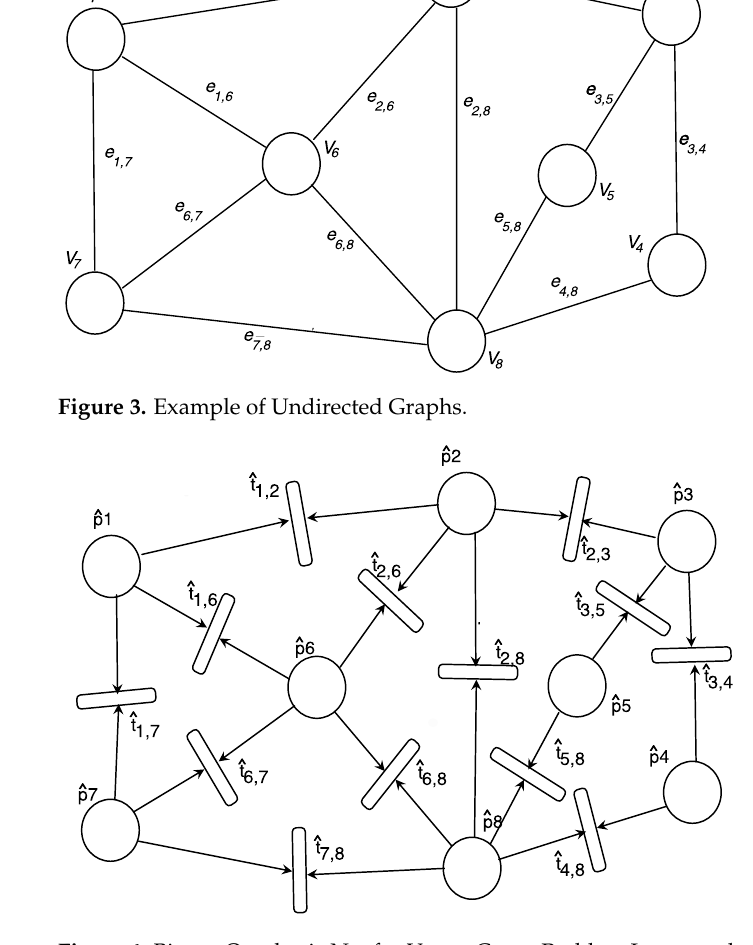
Figure 4. Binary Quadratic Net for Vertex Cover Problem Instance shown in Figure